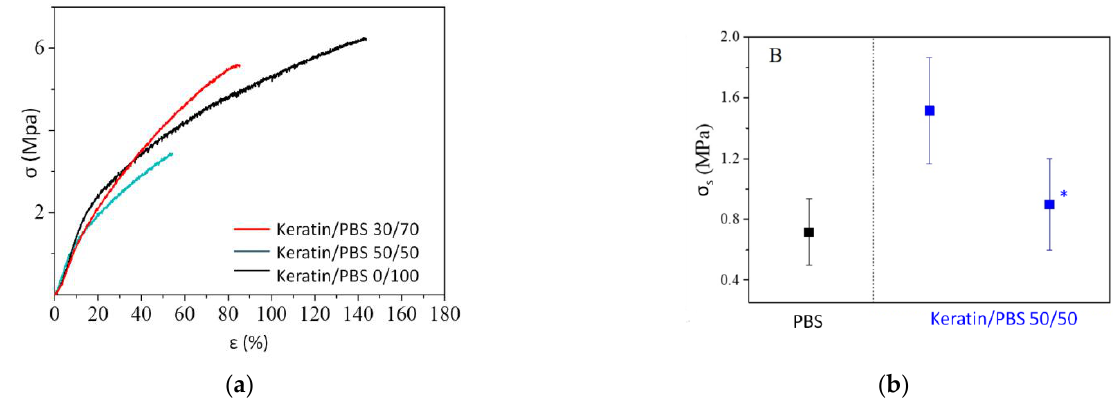
Figure 4. ( a ) Stress-strain curves and ( b ) shear stress values (σ S ) of PBS and keratin/PBS electrospun mats in wet and (*) dry conditions. Table 2. Tensile and adhesion tests data of PBS and Keratin/PBS 50/50 electrospun mats.